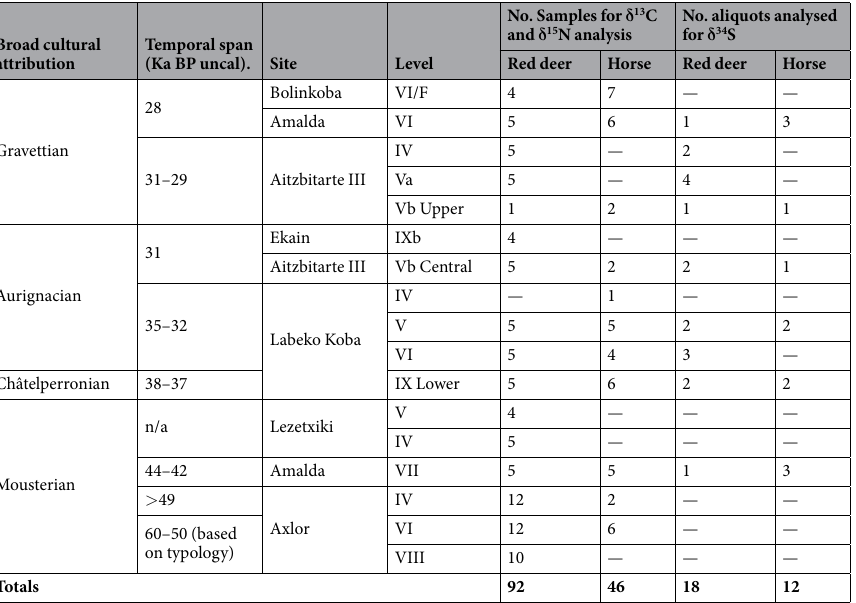
Table 1. Summary of the specimens sampled per sites and archaeological levels and their chrono-cultural